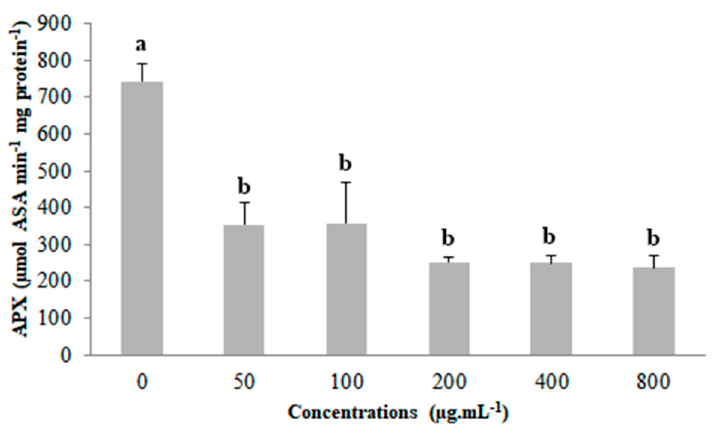
Figure 5. Ascorbate peroxidase (APX) activity in Lactuca sativa seedlings exposed to the different concentrations of coumarin A1. Columns followed by the same letter do not differ statistically by the Scott–Knott test at 5% significance. Bar: standard error.